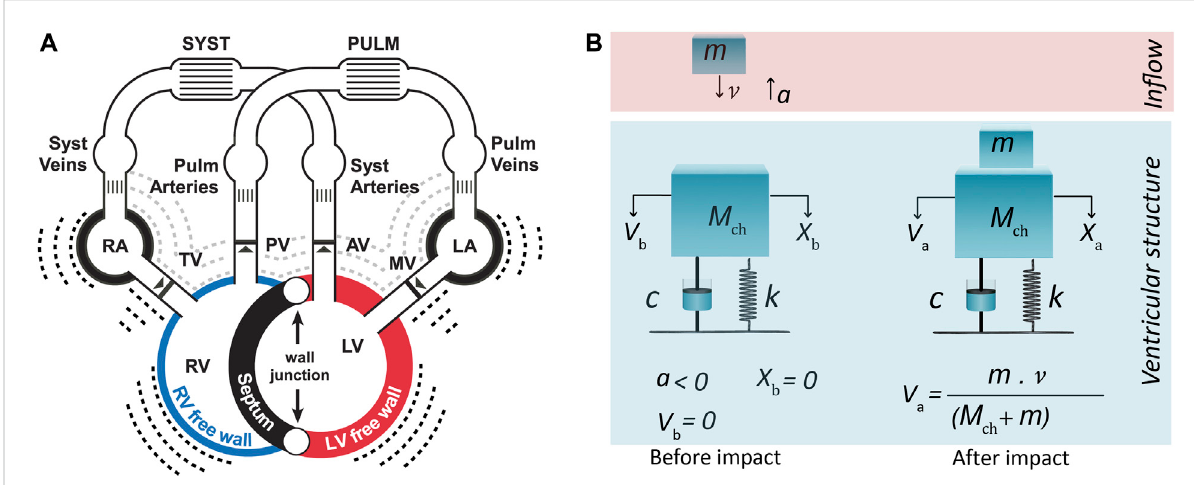
FIGURE 1 (A) CircAdapt model for simulation of cardiovascular mechanics and hemodynamics of the entire circulation (Walmsley et al., 2015). (B) One- degree-of-freedommodelforthirdheartsoundgenerationembeddedinCircAdapt. Themodelbeforeandafterimpactofbloodin fl owfromatrium. In fl ow blood mass ( m ) hits ventricular cardiohemic mass ( M ch ) and imparts momentum ( m · v ) to the cardiohemic structure. Panel (a): LA, left atrium; LV,leftventricle;MV,mitralvalve;PV,pulmonaryvalve;RA,rightatrium;RV,rightventricle;TV,tricuspidvalve.Panel(b):a,accelerationofin fl ow blood before impact, c, damping factor; k, spring factor; M ch : Ventricular cardiohemic mass (was obtained by summation of the CircAdapt-derived chamber wall ( m myo ) and blood volumes ( m bld )) , m , in fl ow blood mass; v , velocity of in fl ow blood mass before impact; V b , velocity of ventricular cardiohemicmass( M ch )before impact; V a ,velocityofventricularmasses ( M ch +m )after inelasticimpact; X a ,movementofventricularmasses( M ch + m ) after impact; X b , movement of ventricular cardiohemic mass ( M ch ) before